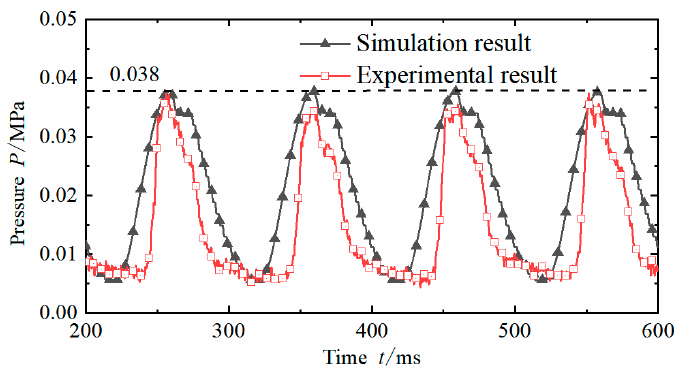
Figure 8. Pressure of direct-drive pump outlet hydraulic line.